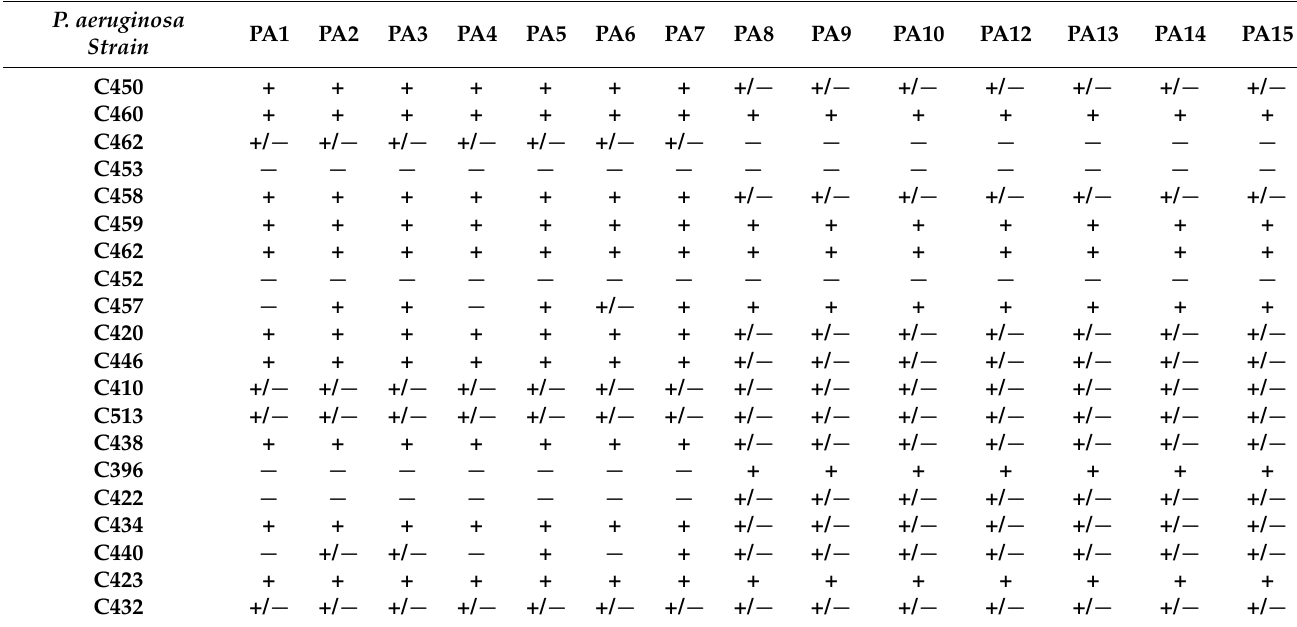
Table 1. Summary of Bacteriophage Host Range. * Based on the degree of lysis on the bacterial lawn, the spots were differentiated into three categories: sensitive (+), semi-sensitive (+/ − ) or non-sensitive ( − ). C450 to C457 represent P. aeruginosa strains isolated from cystic fibrosis patients whilst C420 to C432 represent P. aeruginosa strains isolated from non-cystic fibrosis